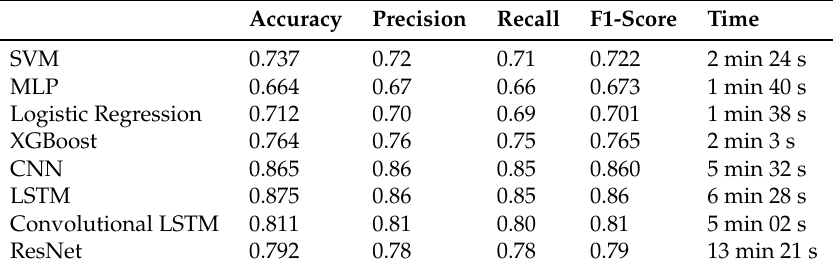
Table 5. Summary of